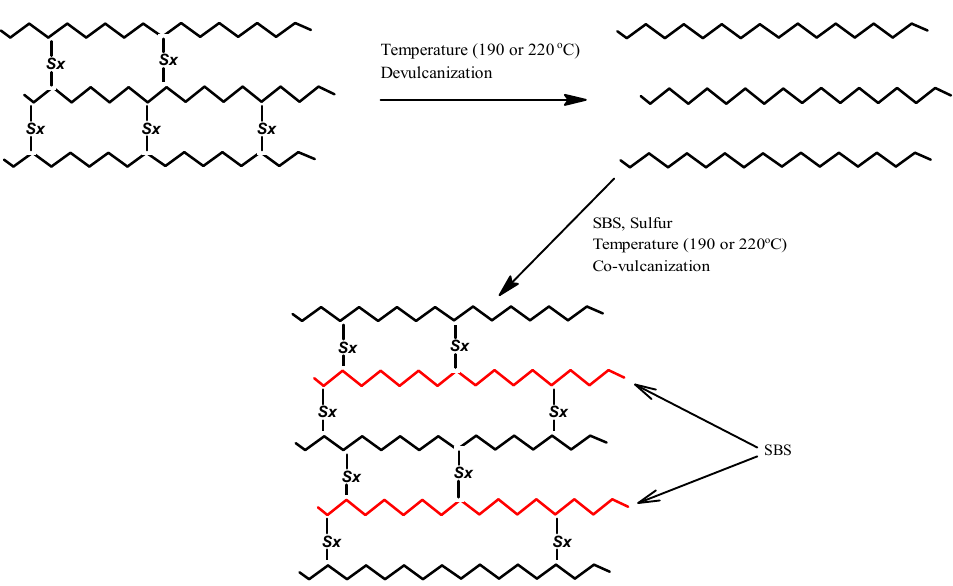
Figure 1. Scheme showing the chemical modification of the studied bitumen.